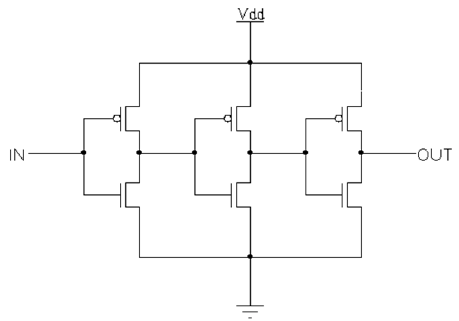
Figure 5. TIQ comparator.